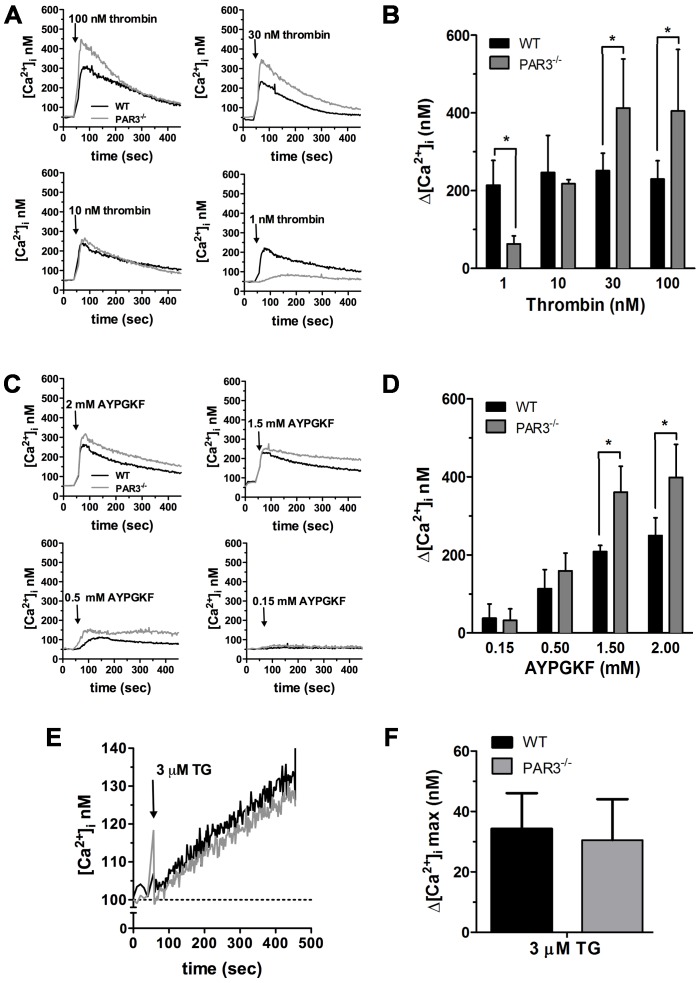
Dose response curve of Ca2+ mobilization in the absence of extracellular Ca2+ in mouse platelets.Fura 2-loaded wild type (black line) and PAR3−/− (gray line) platelets were resuspended in Ca2+-free medium (0.1 mM EGTA was added at the time of experiment). Representative tracings are shown from platelets activated with the indicated concentrations of: (A) thrombin (1–100 nM), (C) AYPGKF (0.15–2 mM), or (E) 3 µM thapsigargin (TG). Quantitation of the change in peak Ca2+ mobilization in platelets stimulated with: (B) thrombin, (D) AYPGKF, or (F) thapsigargin. The results are the mean (± SD) of three independent experiments (* p<0.05).